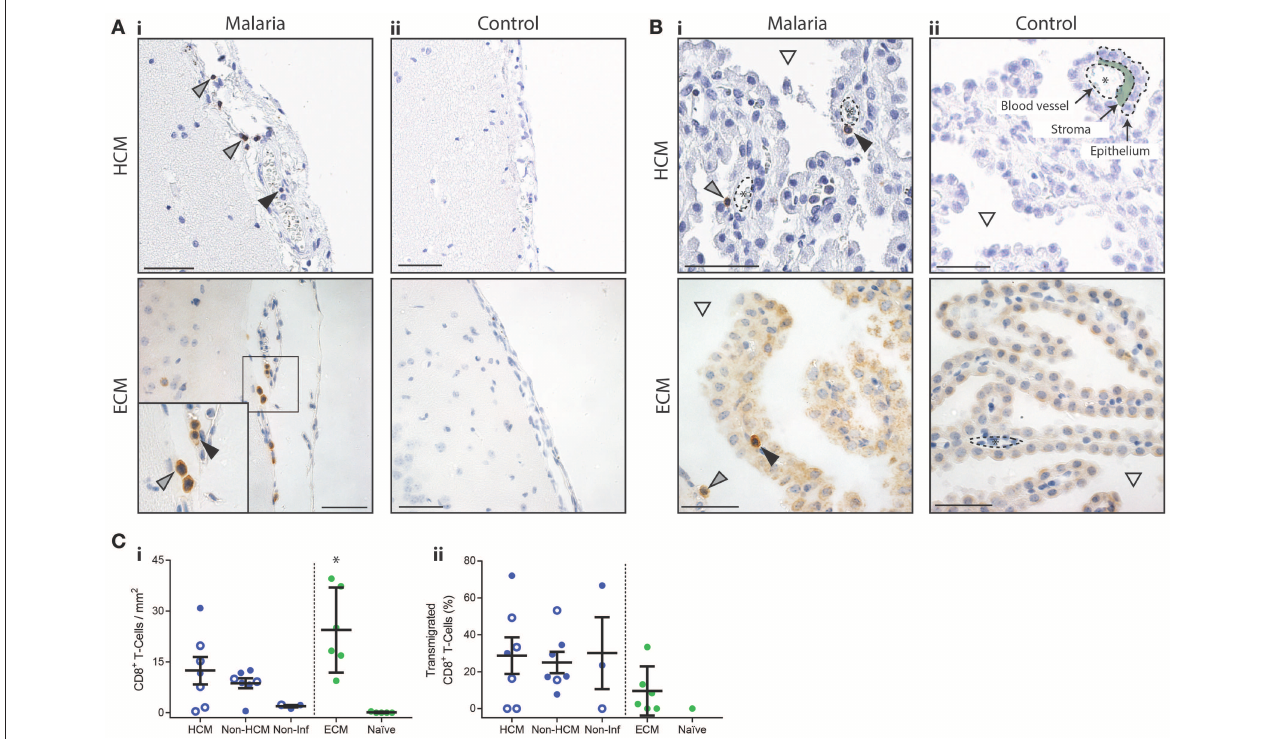
FIGURE 2 | Distribution of CD8 + T cells in the leptomeninges and choroid plexus in HCM and ECM. The presence of CD8 + T cells in the leptomeninges and choroid plexus was assessed by immunohistochemistry in fatal HCM cases, in C57BL/6 mice that developed late-stage ECM after Pb ANKA infection, and in appropriate controls. (A) Representative images of the leptomeninges from HCM and ECM cases showing CD8 + T cells in the lumen of pial vessels (black arrows), and in the subarachnoid space (gray arrows). (B) Representative images of the choroid plexus from HCM and ECM cases showing CD8 + T cells in the stroma or lumen (asterisks) of blood vessels (black arrows), or that have transmigrated into the ventricle (gray arrows; white triangle indicates CSF-filled ventricle). (C) (Ci) Absolute numbers of CD8 + T cells per mm 2 of choroid plexus; (Cii) percentage of CD8 + T cells in the choroid plexus that had transmigrated into the ventricle. HCM = CM1 (filled circles) and CM2 (open circles) cases, Non-HCM = CM3 (filled circles) and CM7 (open circles), Non-Inf = CM9 (filled circles) and CM11 (open circles). Scale bars = 50 µ m. * p < 0.05. Human cases were compared by one-way ANOVA with Holm-Sidak’s multiple comparisons test, ECM was compared to naïve by Students t